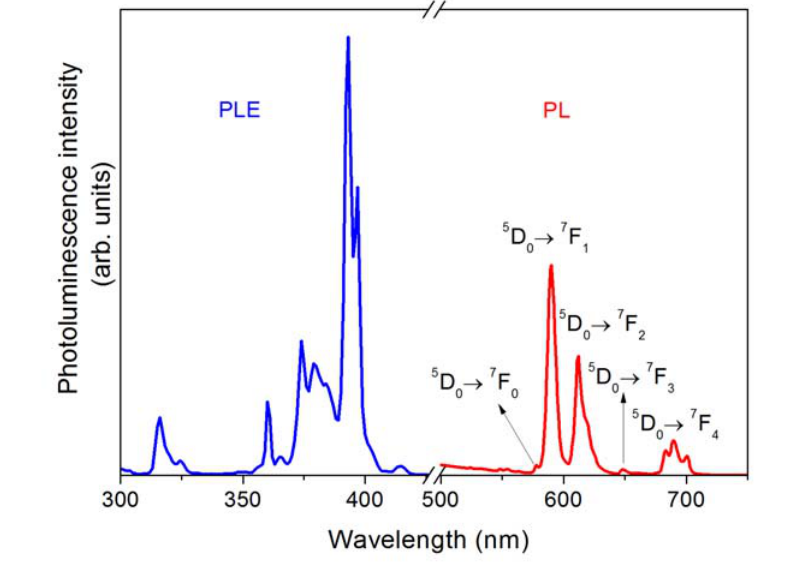
5 D (J = 0, 1, 2, 3, and 4) transitions of Eu 3+ ion in CaF ↔ 7 F 0 J